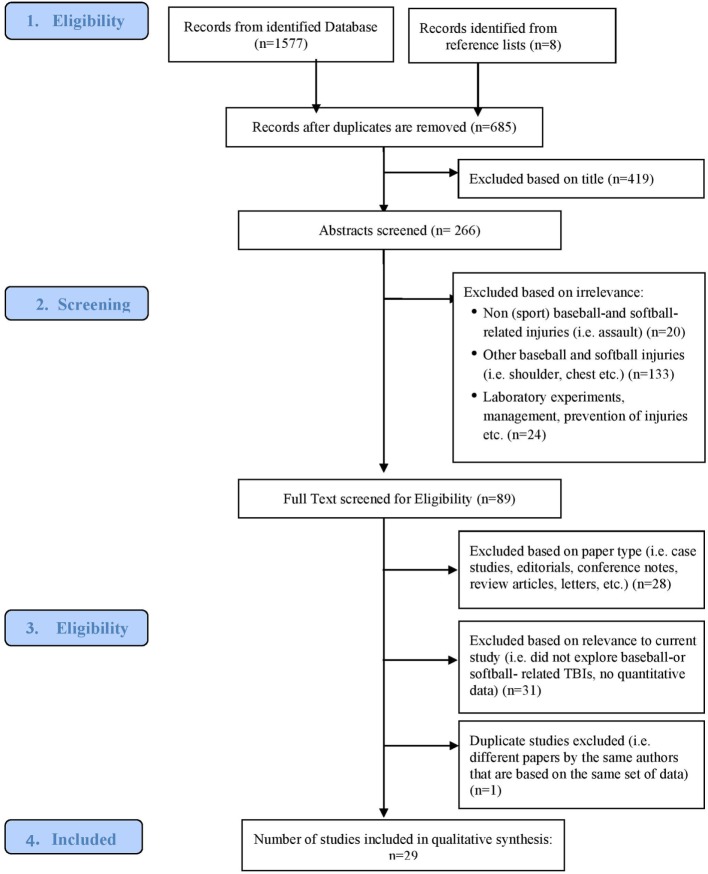
Consort diagram.